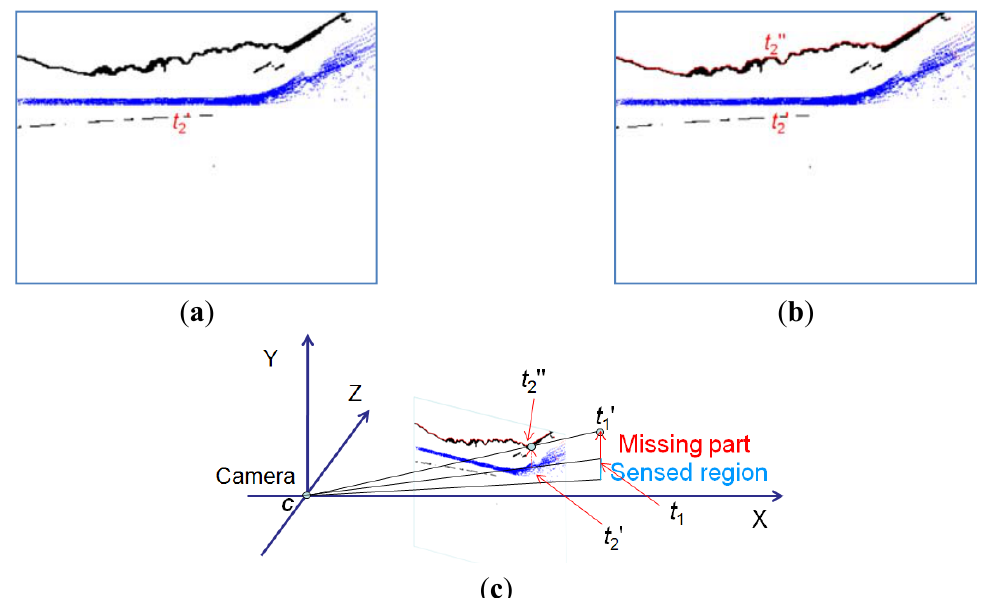
Figure 9. Boundary detection for non-ground objects. ( a ) Projection results from vertices . ( b ) Non-ground objects boundary detection results in 2D image. in dataset T 1 ( c ) 3D boundary detection